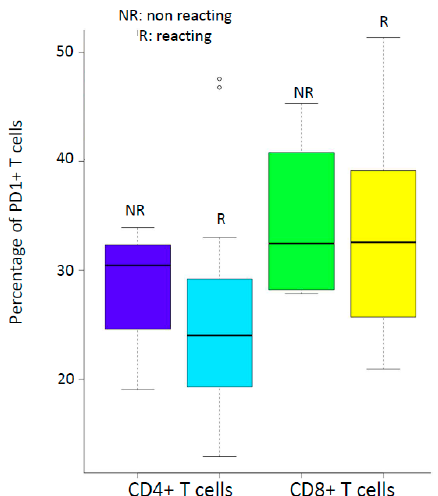
Figure 2. Reactivity to HFVAC peptides by ELISPOT according to the percentages of CD4 + and CD8 + T cells expressing PD-1.